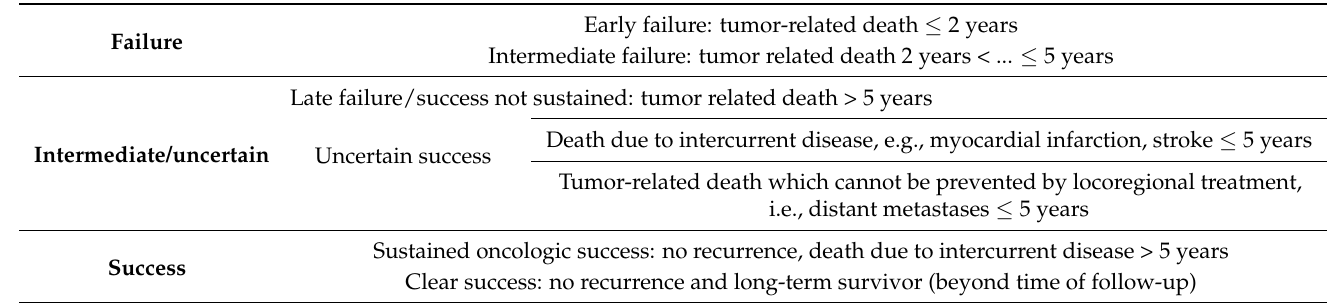
Table 8. Differential matrix for the definition of success of adjuvant